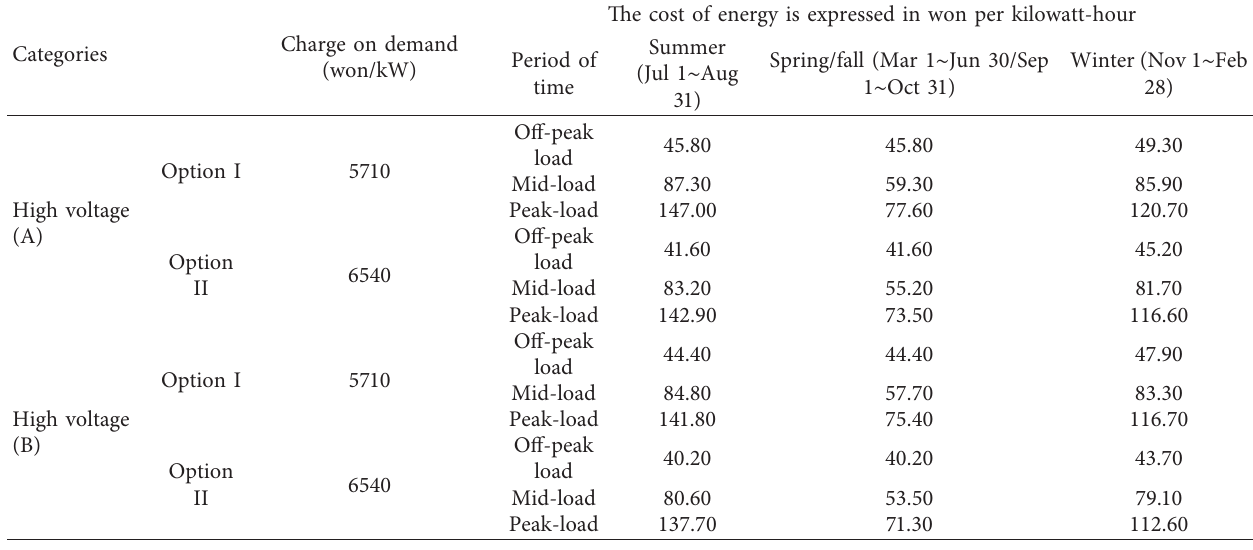
Figure 2: (a) Smart meter. (b) Steel industry manufacturing sector. Table 1: Different types of load and their timings